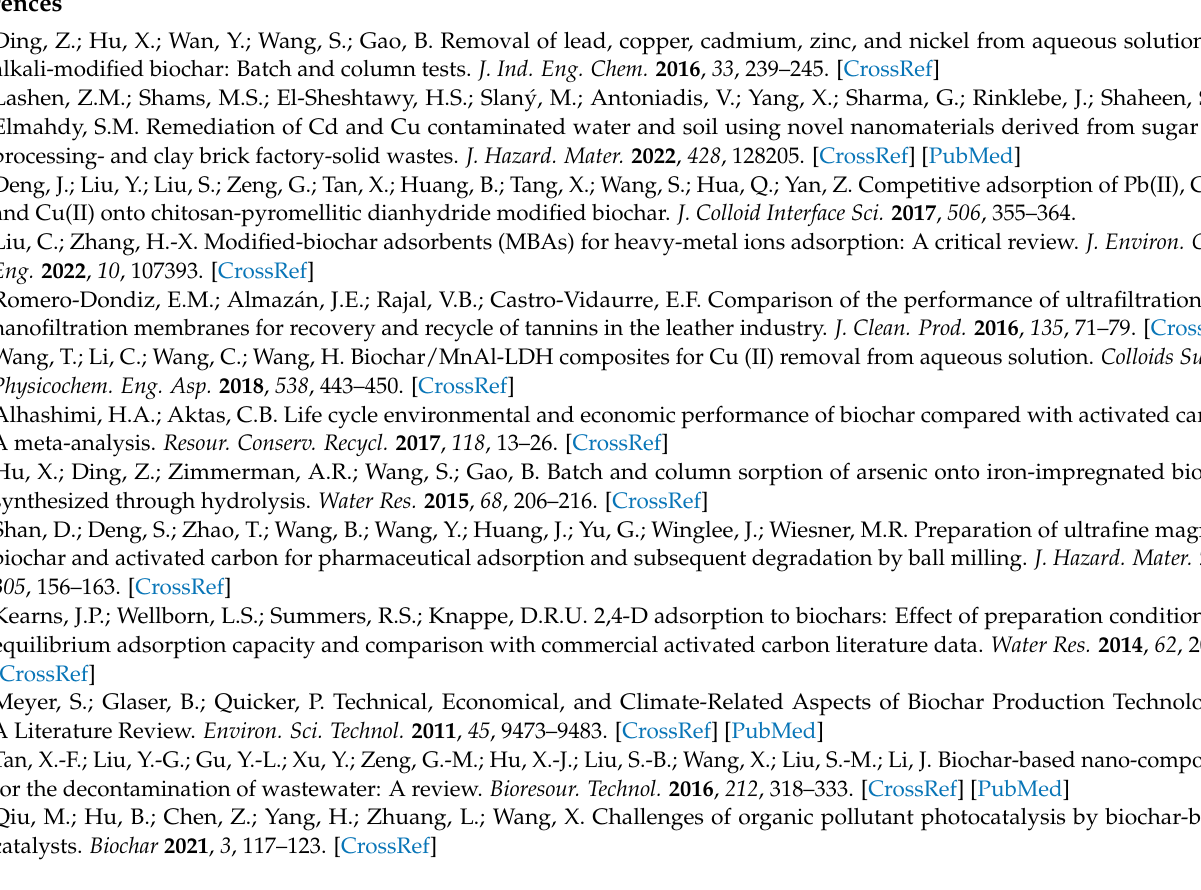
Figure S1: SEM images of BC (a) and GBC (b), Figure S2: XRD patterns of BC and GBC, Figure S3: FTIR spectra of BC and GBC, Figure S4: XPS full-spectrum scanning diagram of BC and GBC, Figure S5: XPS Spectra of C1s (a), N1s (b) in BC, and C1s (c), N1s (d) in GBC, Figure S6: Effect of initial pH value of the solution on competitive adsorption of Cd, Pb, and Cu on GBC, Figure S7: XPS peak plot of Cu2p in GBC after Cu adsorption, Figure S8: The adsorption-desorption cycles of Pb, Cd and Cu on GBC (a); adsorption of Pb, Cd and Cu by GBC in different water samples (b), Table S1: BC and GBC surface properties and ash content, Table S1: BC and GBC surface properties and ash content, Table S2: Content of C, N, and O elements in BC and GBC (%), Table S3: Comparison of maximum adsorption capacity of heavy metal with various adsorbents, Table S4: Water sample parameters of deionized water, tap water and river